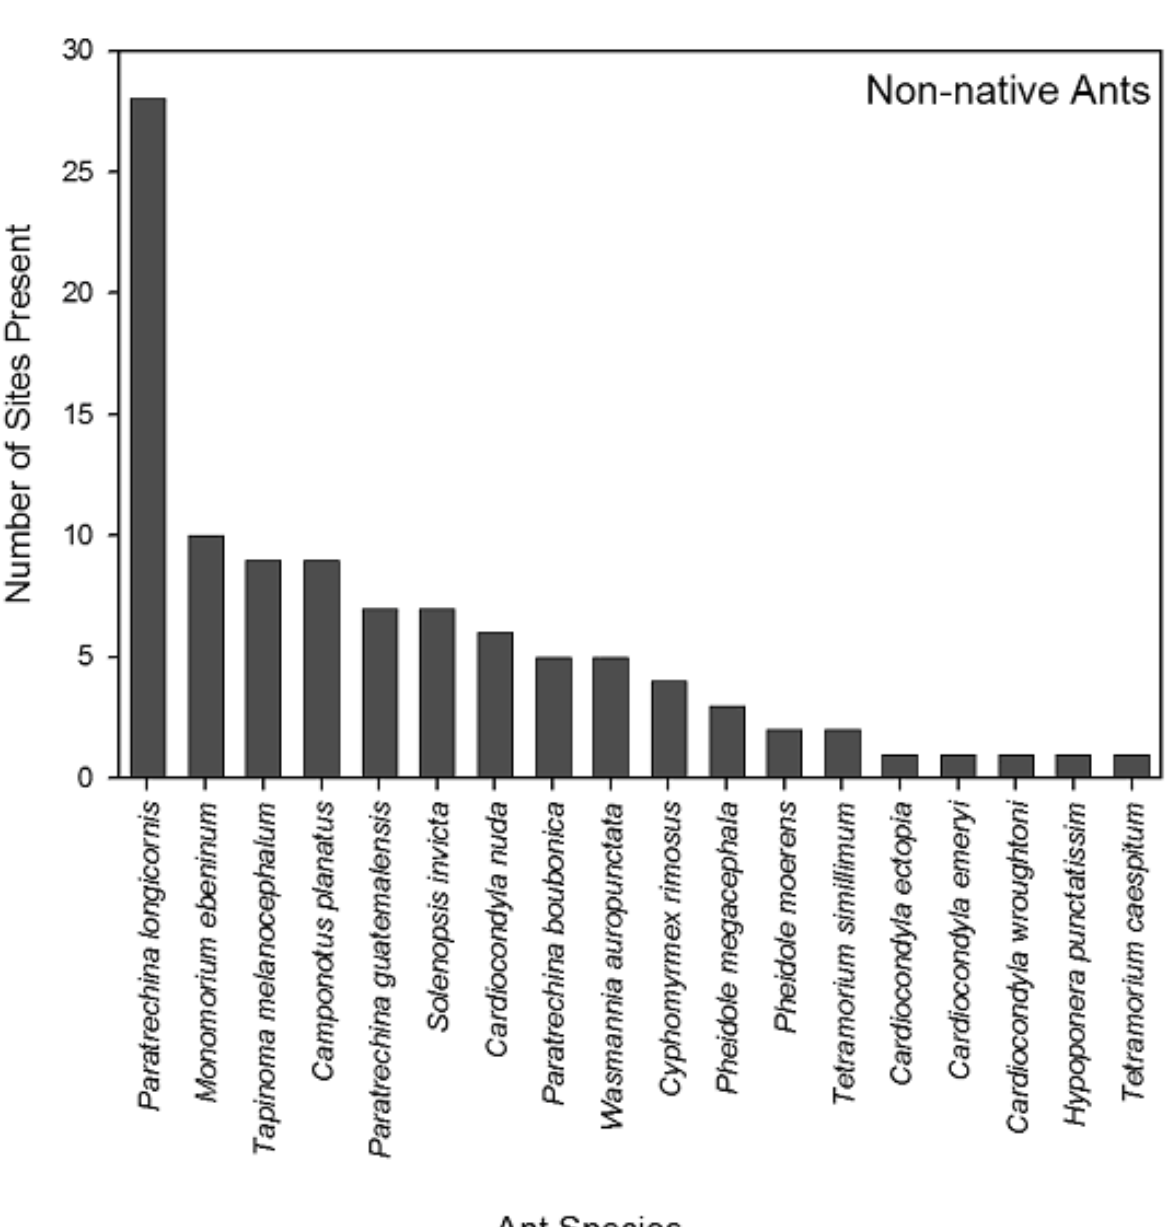
Fig. 3. The number of sites in the Lower Florida Keys that had each non-native species